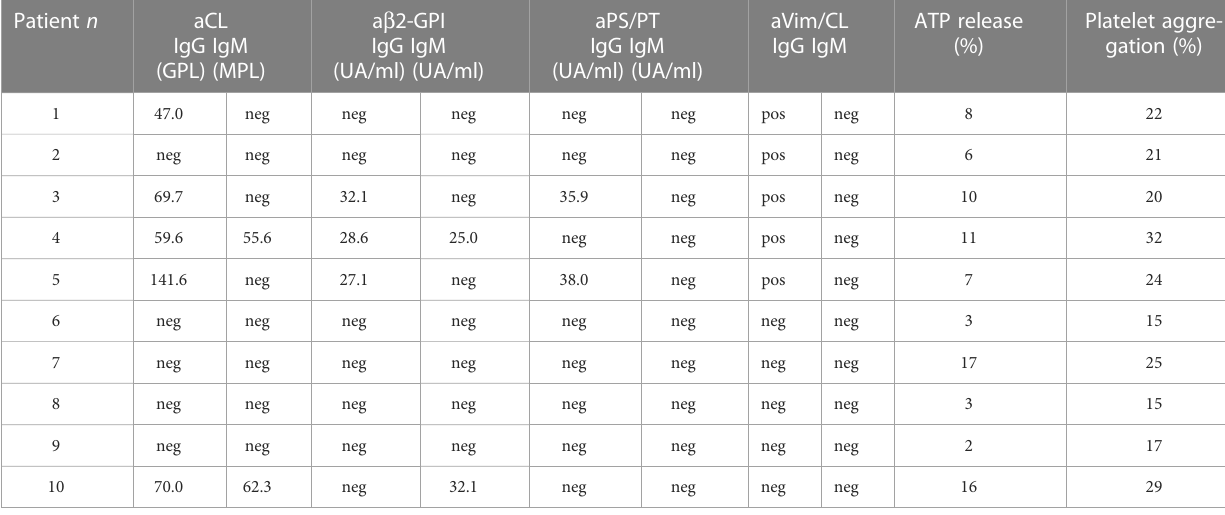
TABLE 2 Positivity of aPL antibodies in the 10 patients with acute ischemic stroke during COVID-19. Patient